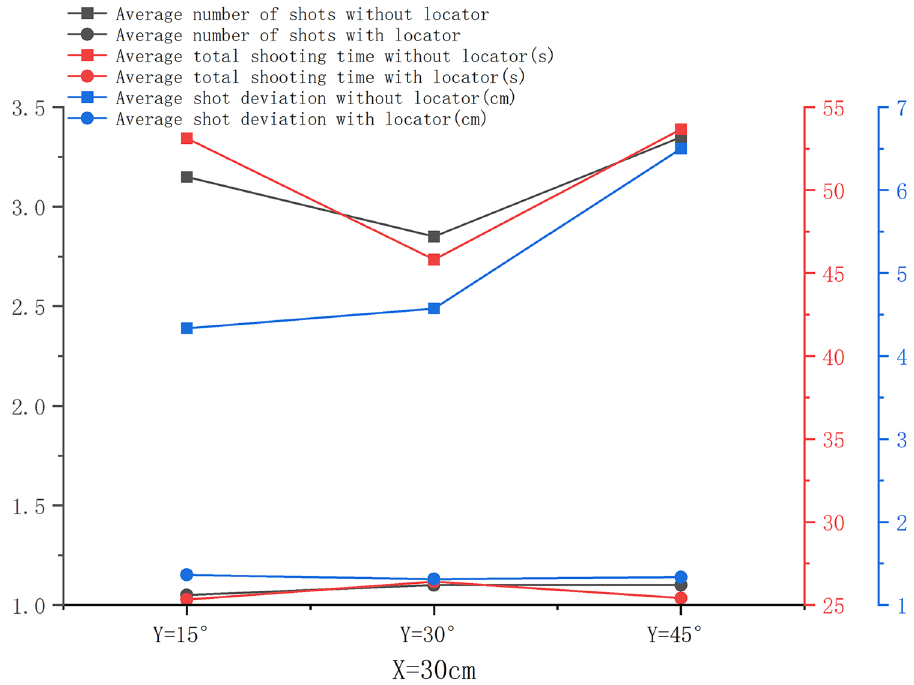
Figure 5. Change trends of the average number of shots, average total shooting time, and average first-shot deviation between the control and experimental groups when X = 30 cm and Y = 15°, 30°, and